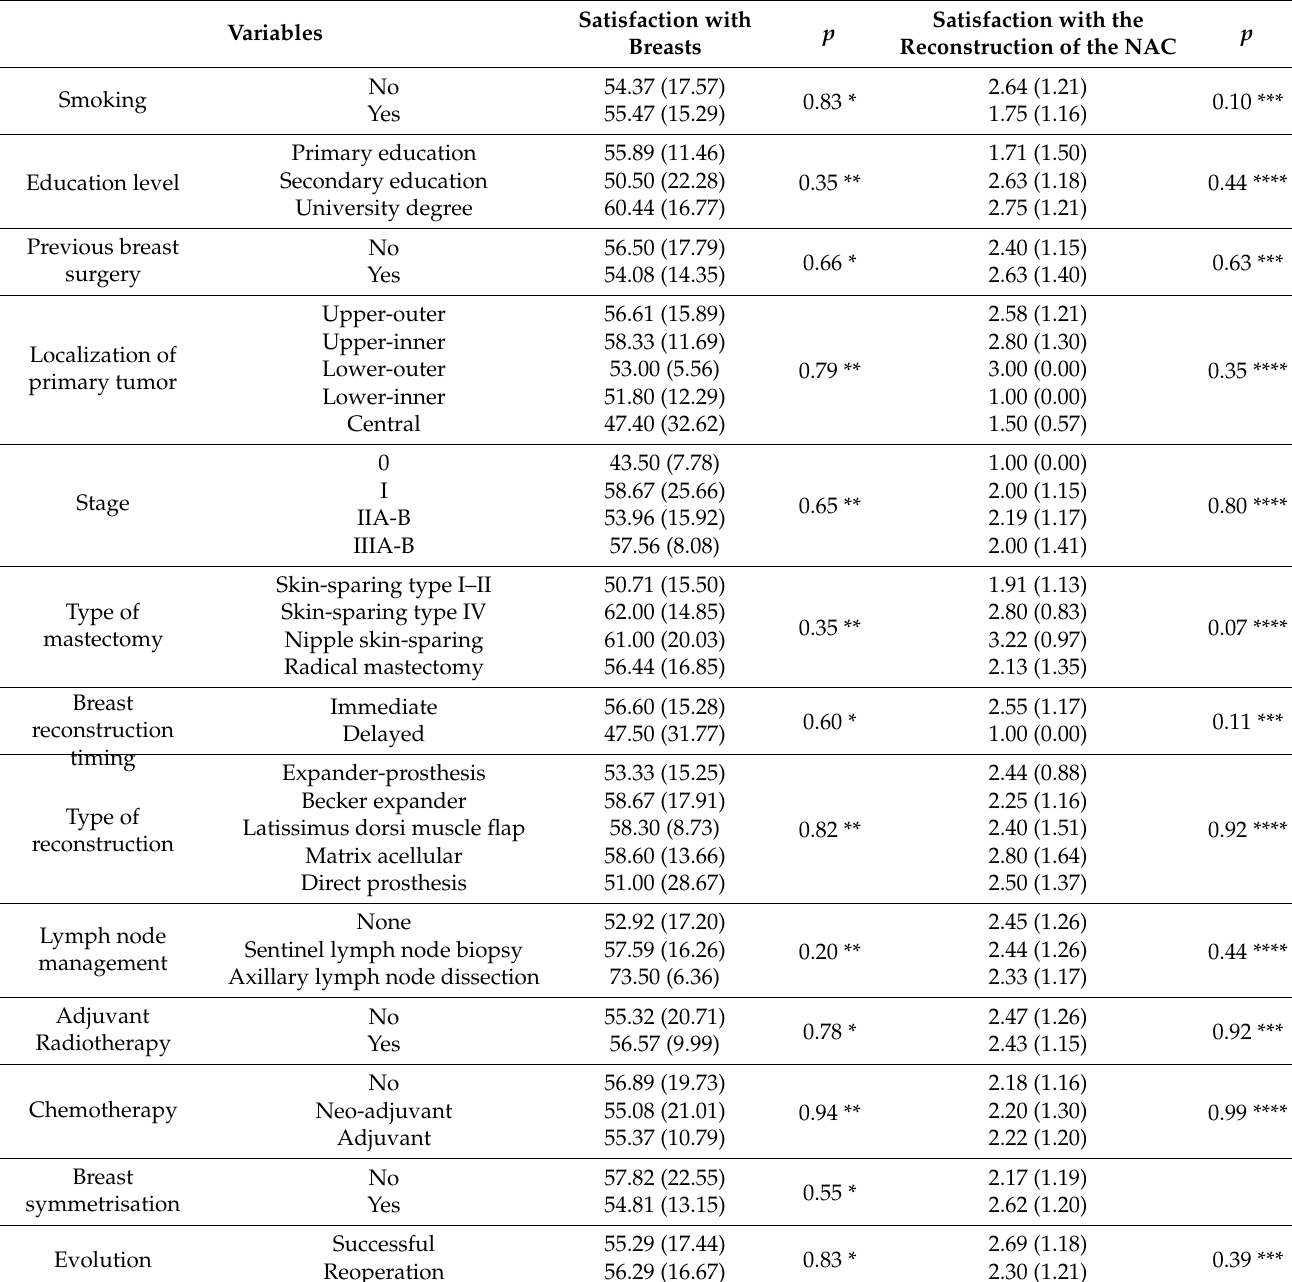
Table 7. Differences between satisfaction with results scales mean scores and qualitative variables studied. Variables